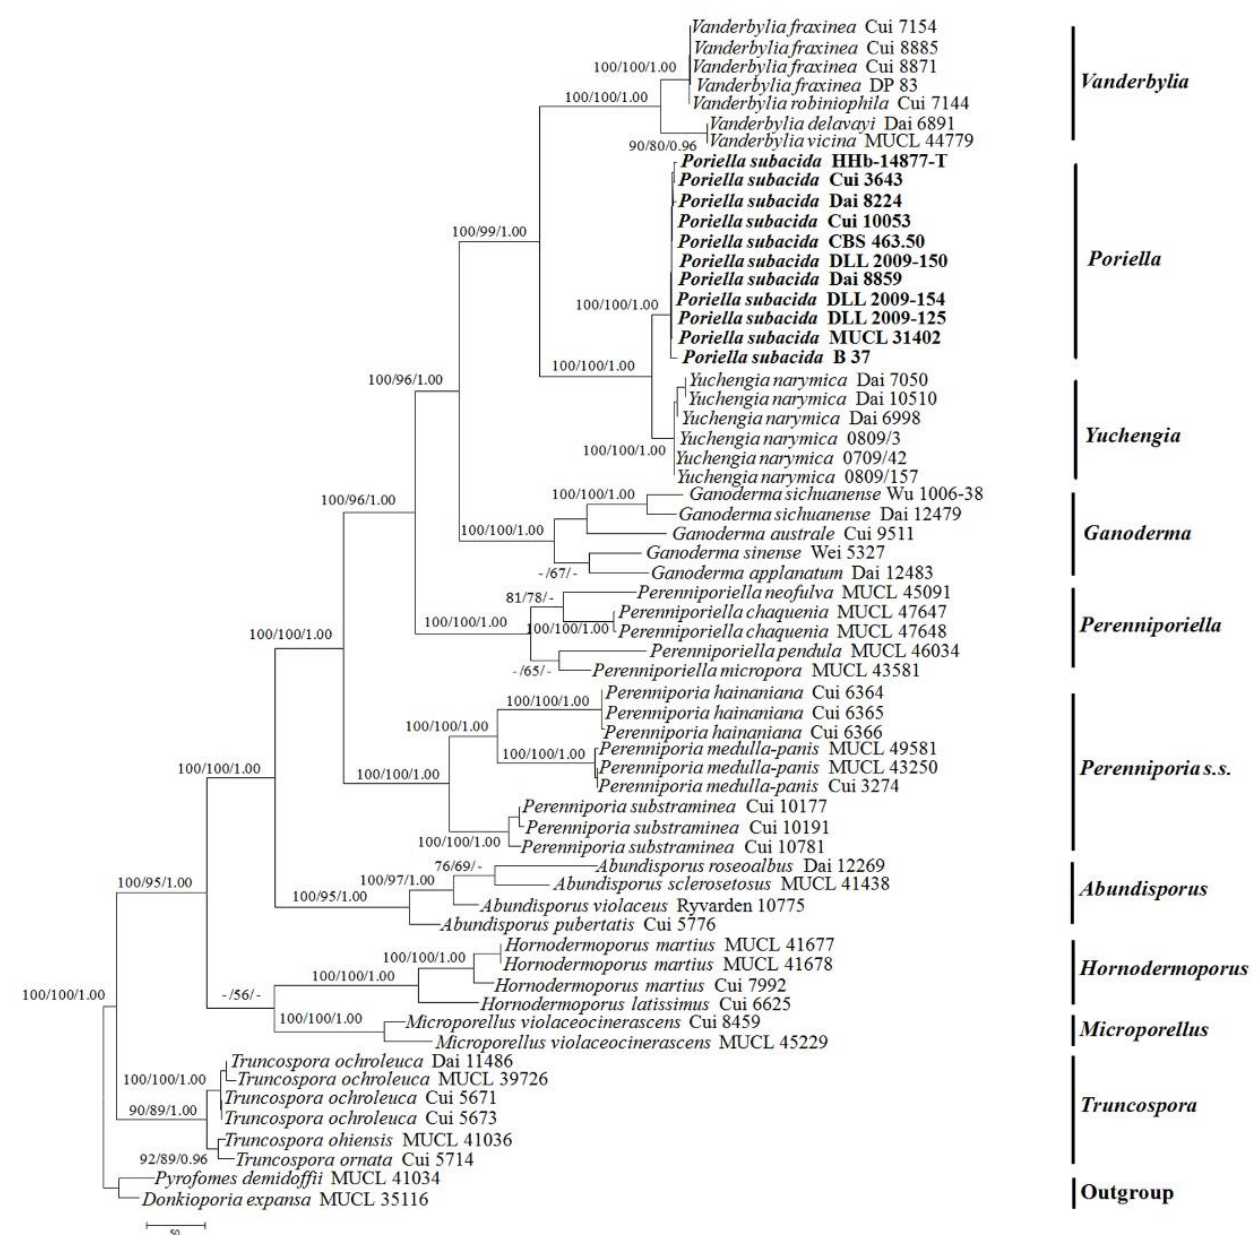
Figure 2 . Maximum Parsimony strict consensus tree illustrating the phylogeny of Poriella subacida , and related species in Perenniporia s . l . based on the combined ITS + 28S + mtSSU + TEF1 sequence datasets . Branches are labeled with maximum likelihood bootstrap higher than 70%, parsimony bootstrap proportions higher than 50% and Bayesian posterior probabilities more than 0 . 95, respectively . Clade names follow [ 15 ].